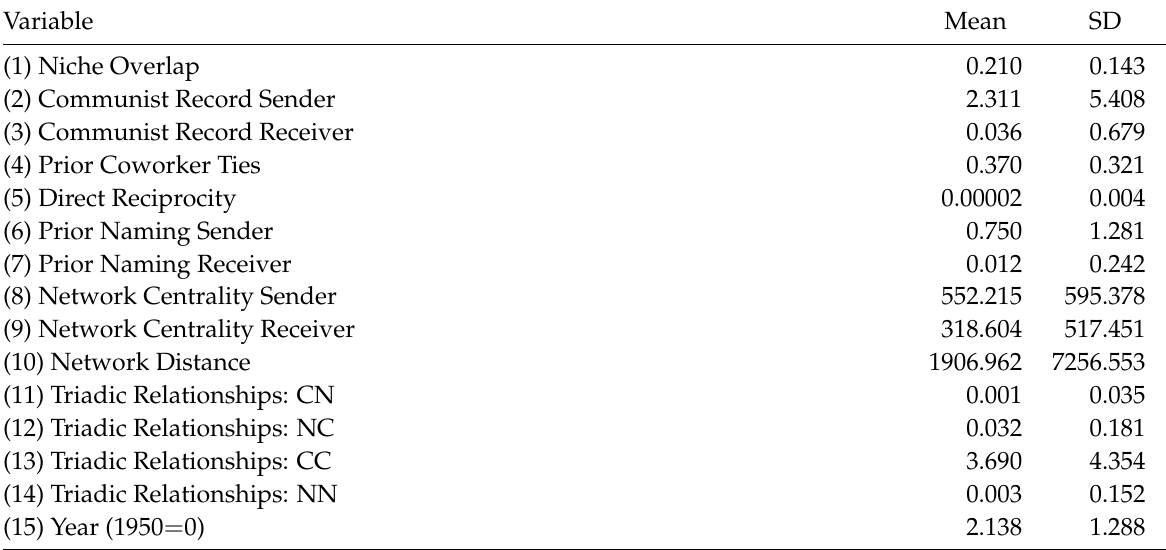
Table 2: Summary Statistics for Analysis of Informing during the HUAC Hearings